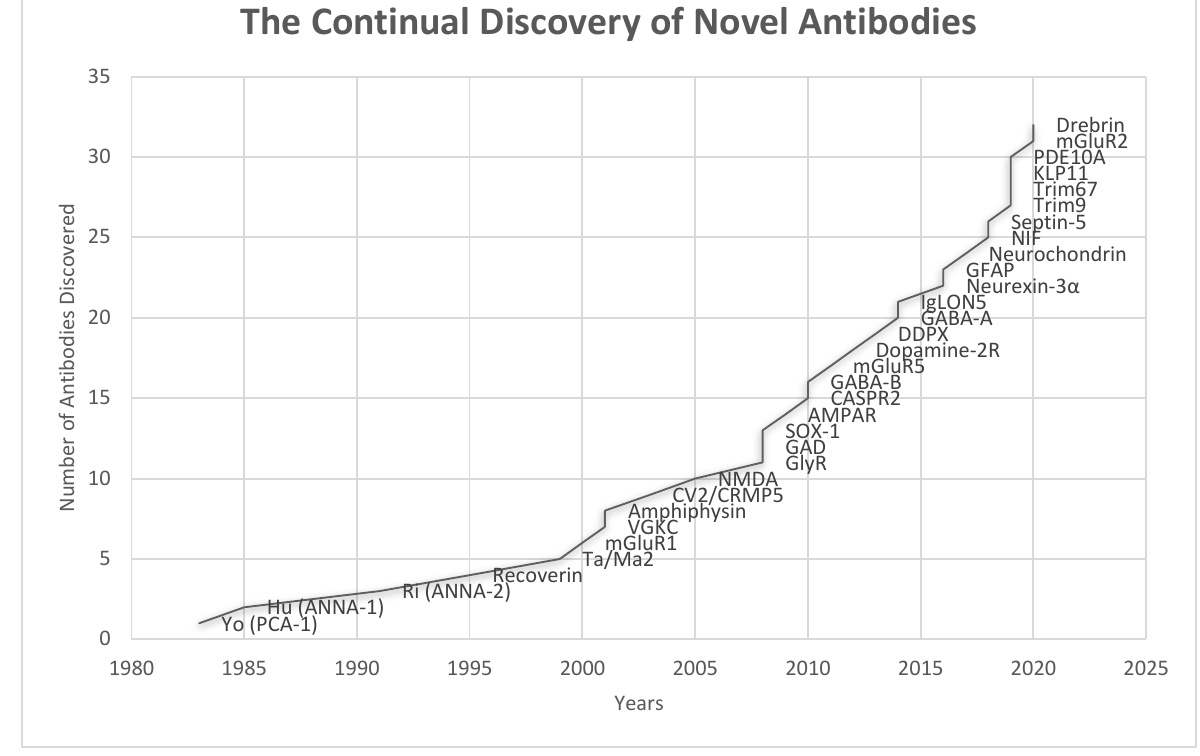
Figure 3. Timeline of the discoveries of various antibodies associated with autoimmune encephalitis (Anti-GAD was discovered in 1988 in patient with stiff person syndrome, but its association with autoimmune encephalitis was not known until 2008) [21 – 41].